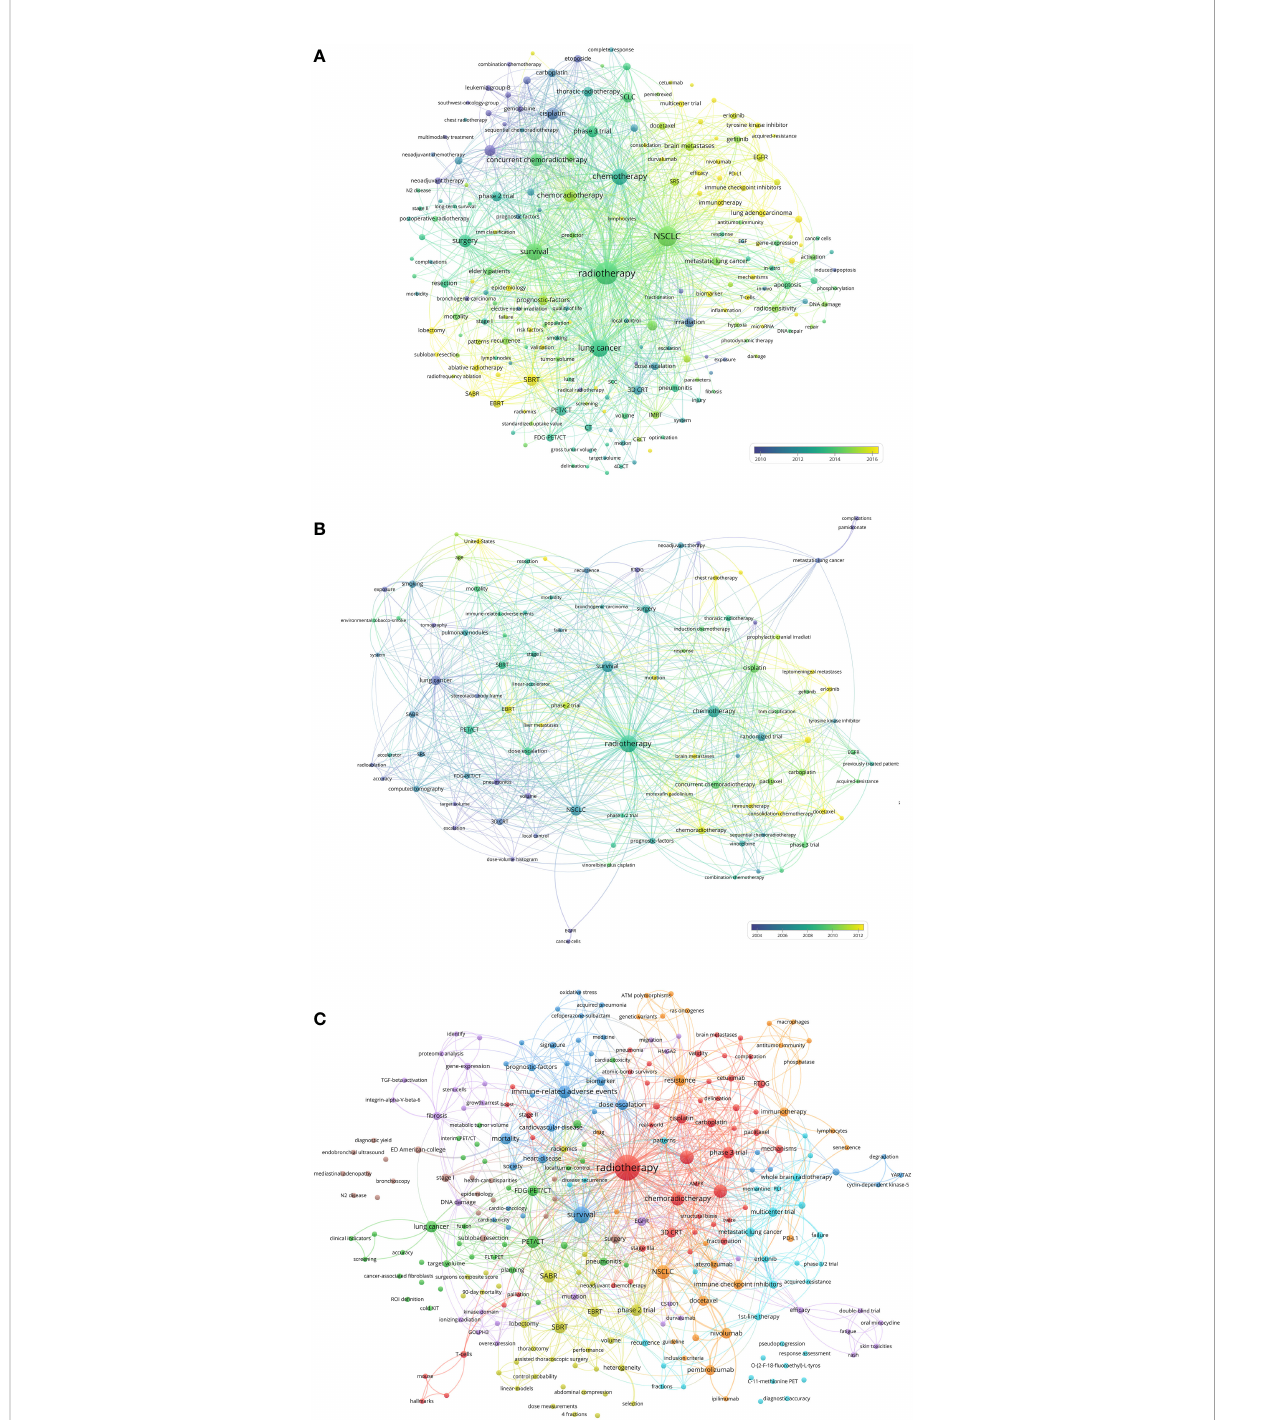
FIGURE 6 (A) Network visualization of keywords that occurred at least 50 times in the 9868 articles. (B) Network visualization of keywords that occurred at least twice in the top-papers. (C) Network visualization of keywords in articles published in top-journals between 2020 and 2022. The circle size represents the number of papers. The breadth of the curves represents the connection